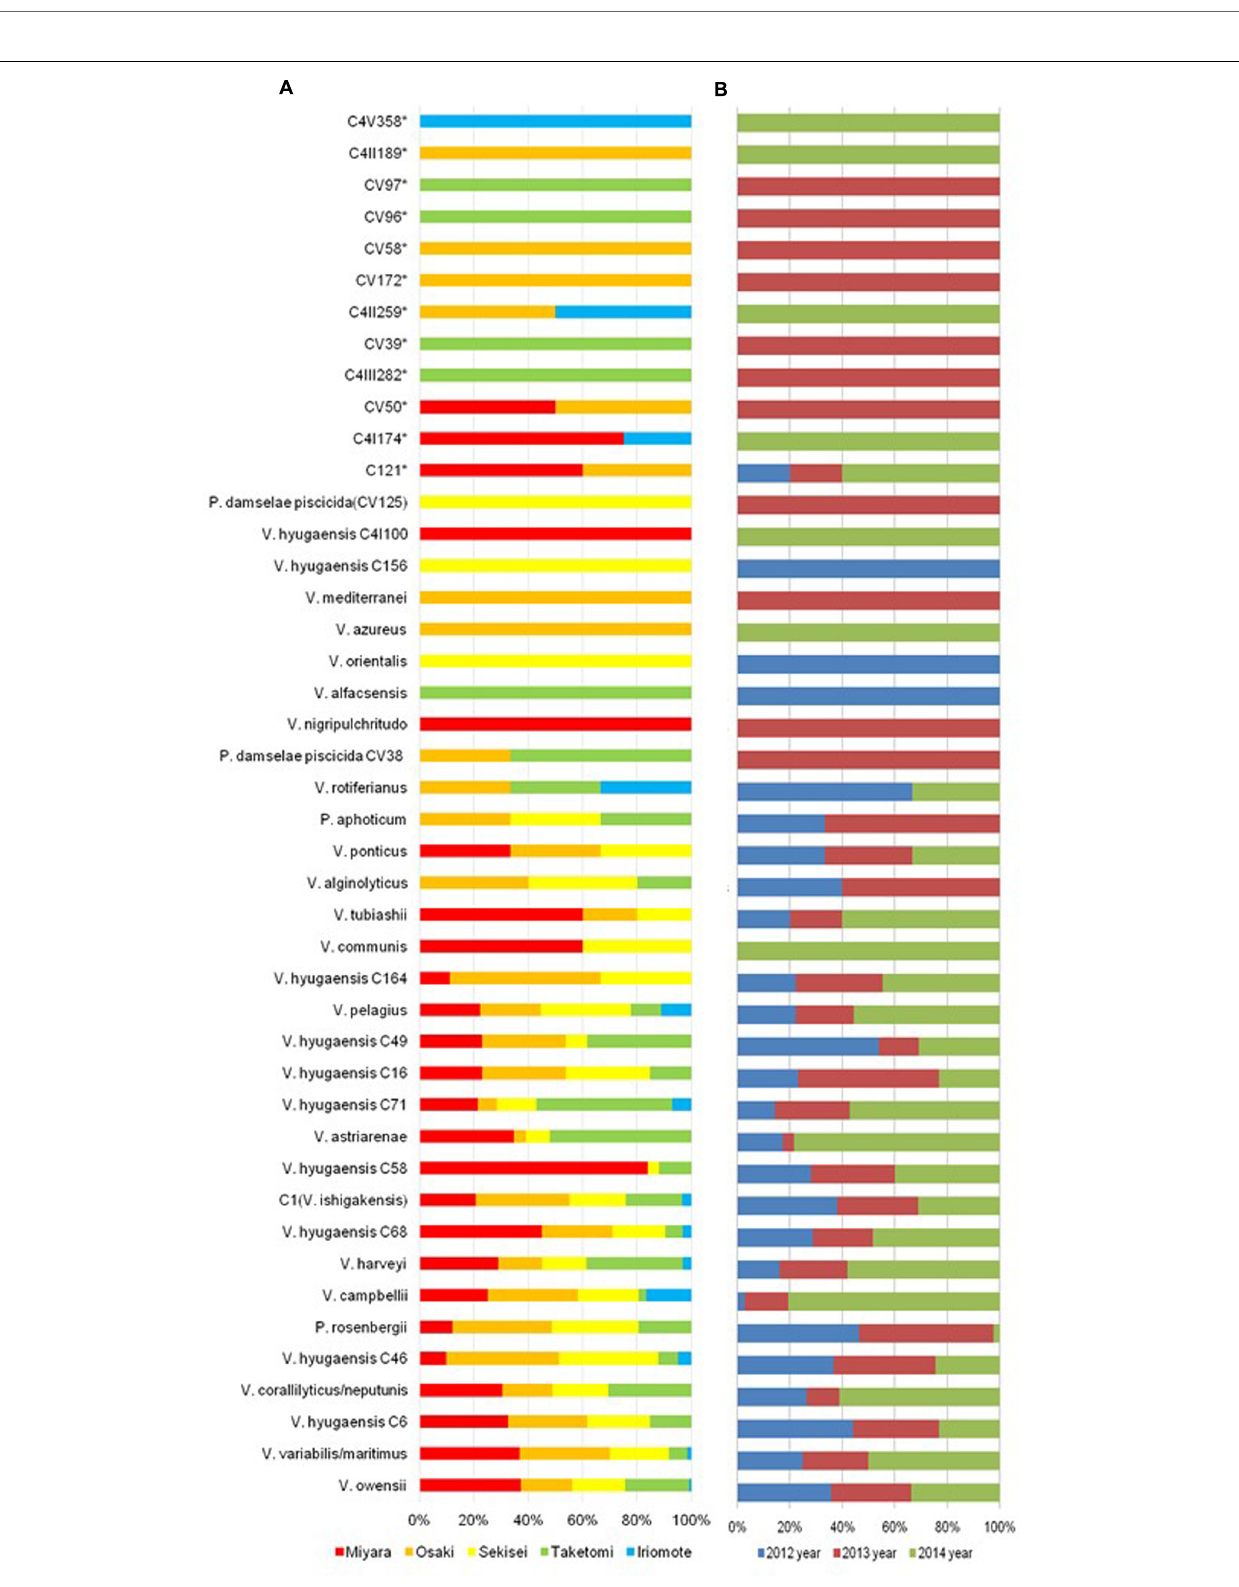
Frontiers in Microbiology |